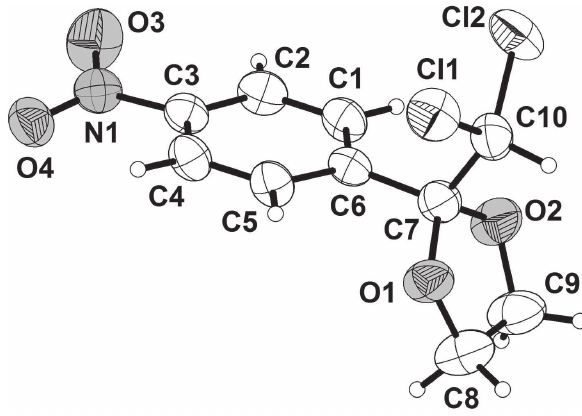
Table 1: Data collection and handling.